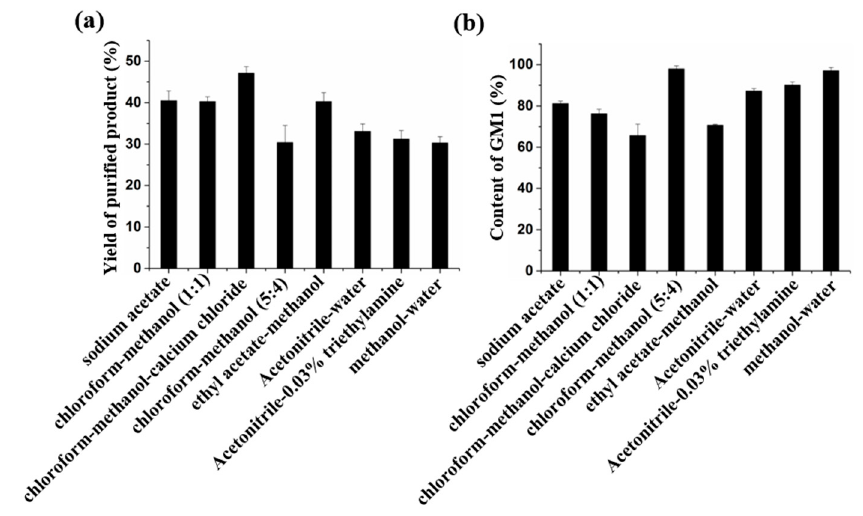
Figure 4. HPLC analysis of the yield and purification of GM1 by different methods. ( a ) The yield of GM1. ( b ) The purification of GM1.